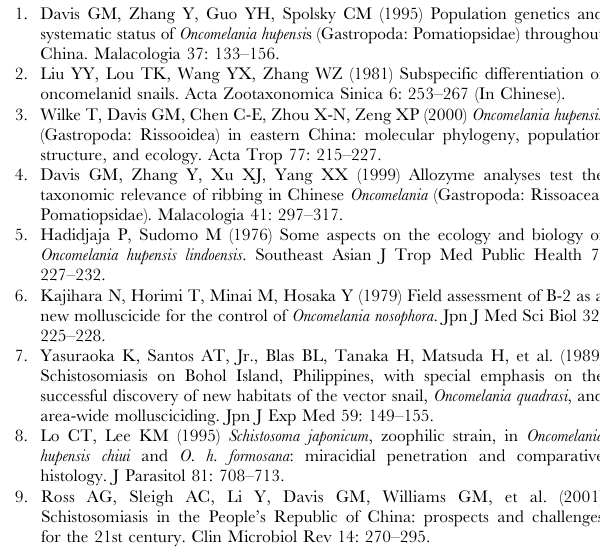
Figure 1. Three anonymous reviewers are sincerely acknowledged for their valuable comments which have significantly improved the